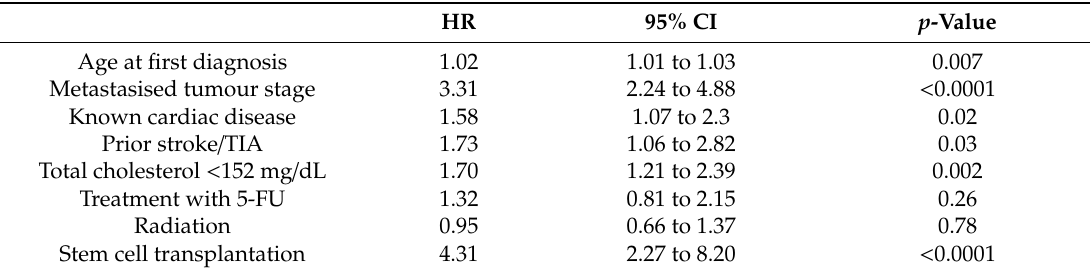
Table 3. Cox regression